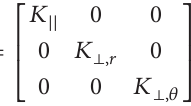
Colatitude80 F 2: Latitudinal relative intensity at Table 2 and using three de�nitions of polar regions :